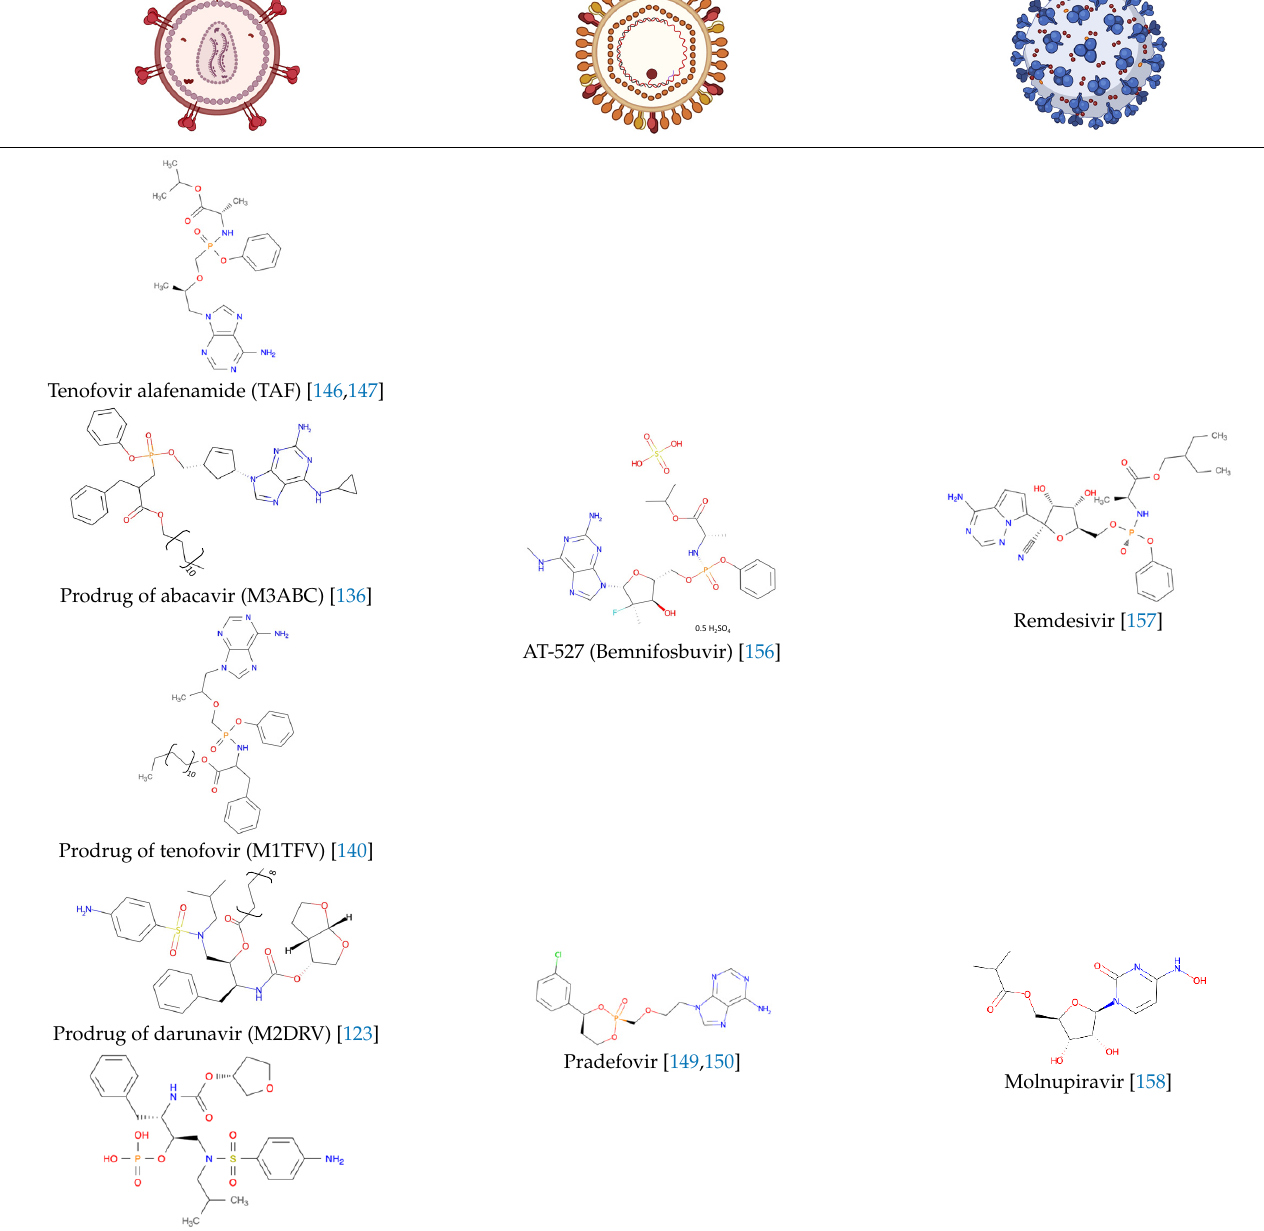
Table 2. Prodrug molecules used for HIV, Hepatitis B, and COVID-19.